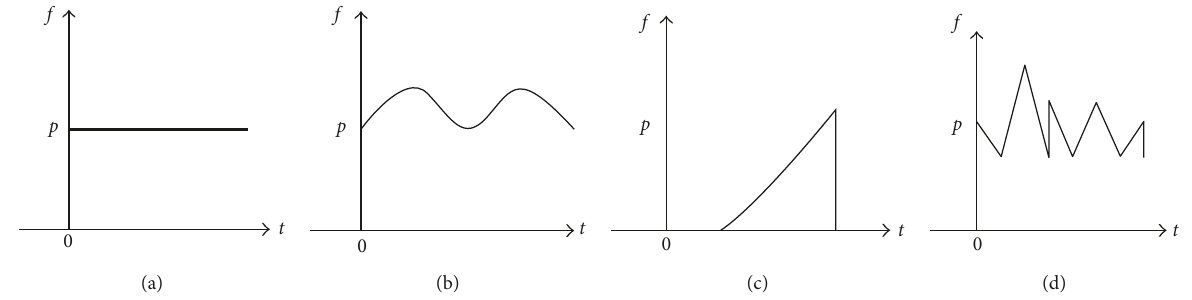
Figure 11: Four typical categories of traffic loads: (a) constant load, (b) harmonic load, (c) impact load, and (d) random load.